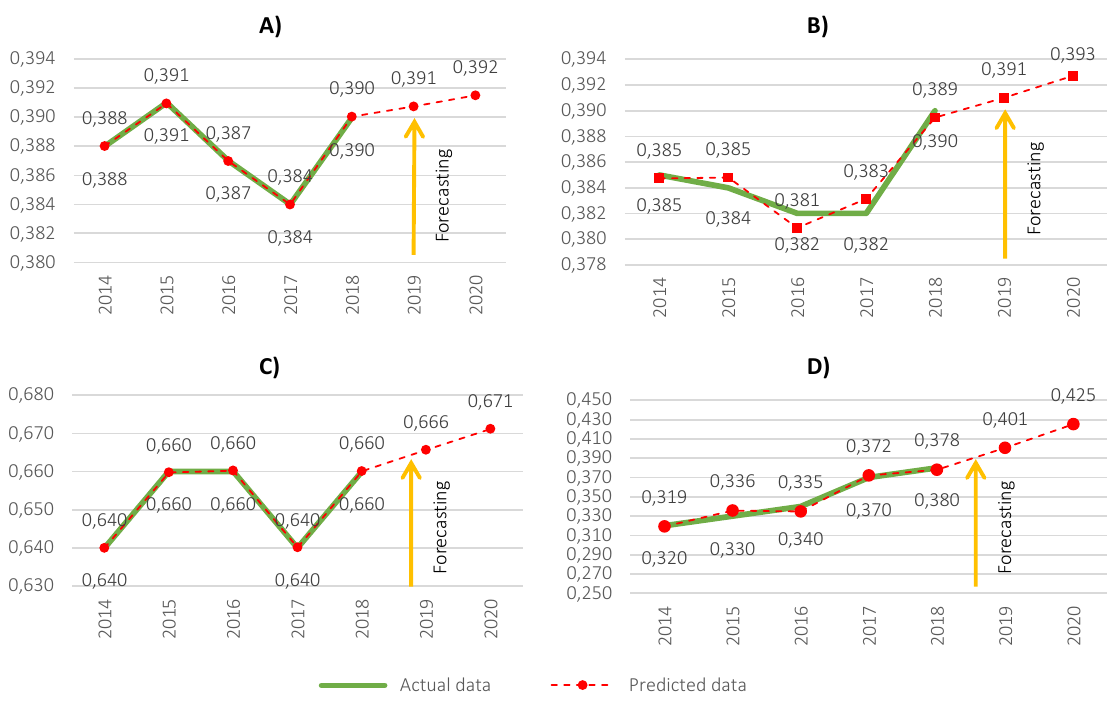
Figure 1. The forecast of financial and economic security integral indicator’s value for enterprises under